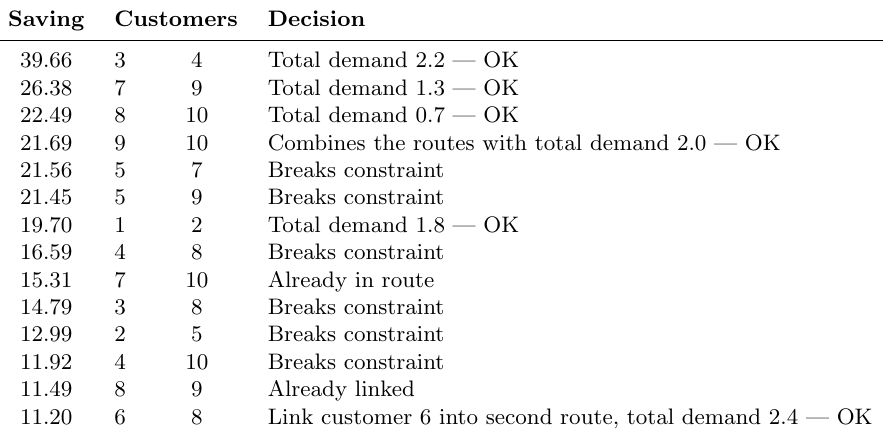
Table 4: Steps in the application of the savings method for the illustrative example.